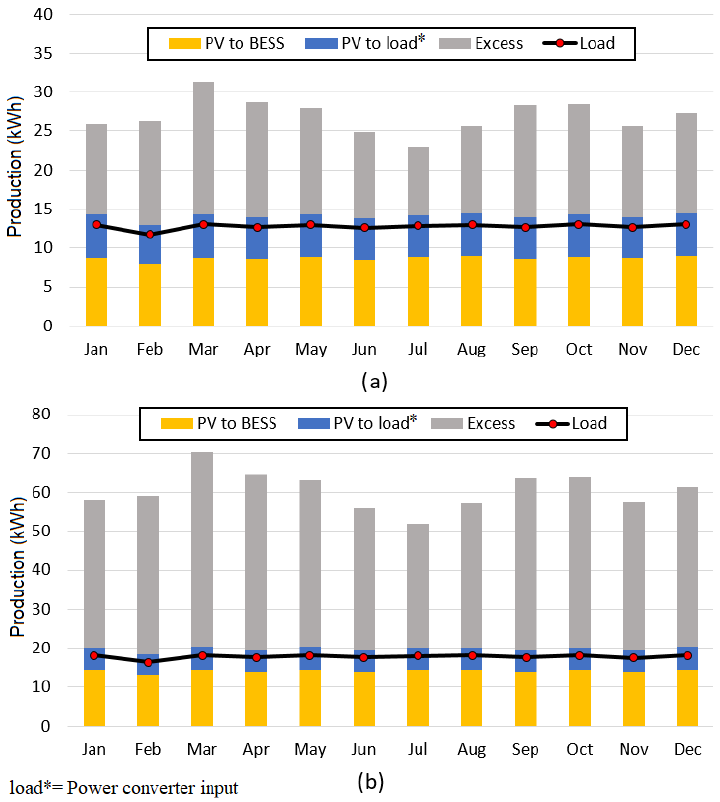
Figure 9. Production from SPVSs and energy consumption of the electrical load in year 15, ( a ) CEEI, and ( b )